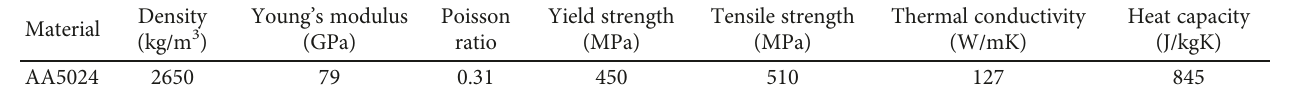
Table 2: Material properties.